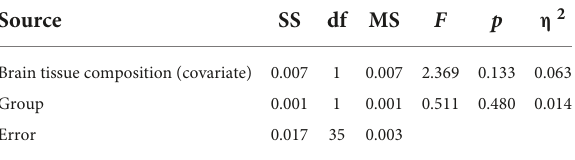
TABLE 5 Analysis of covariance for LDLPFC Glu/Cr+PCr by group with brain tissue composition as a function of age (Age, LDLPFC %GM and LDLPFC %WM) as